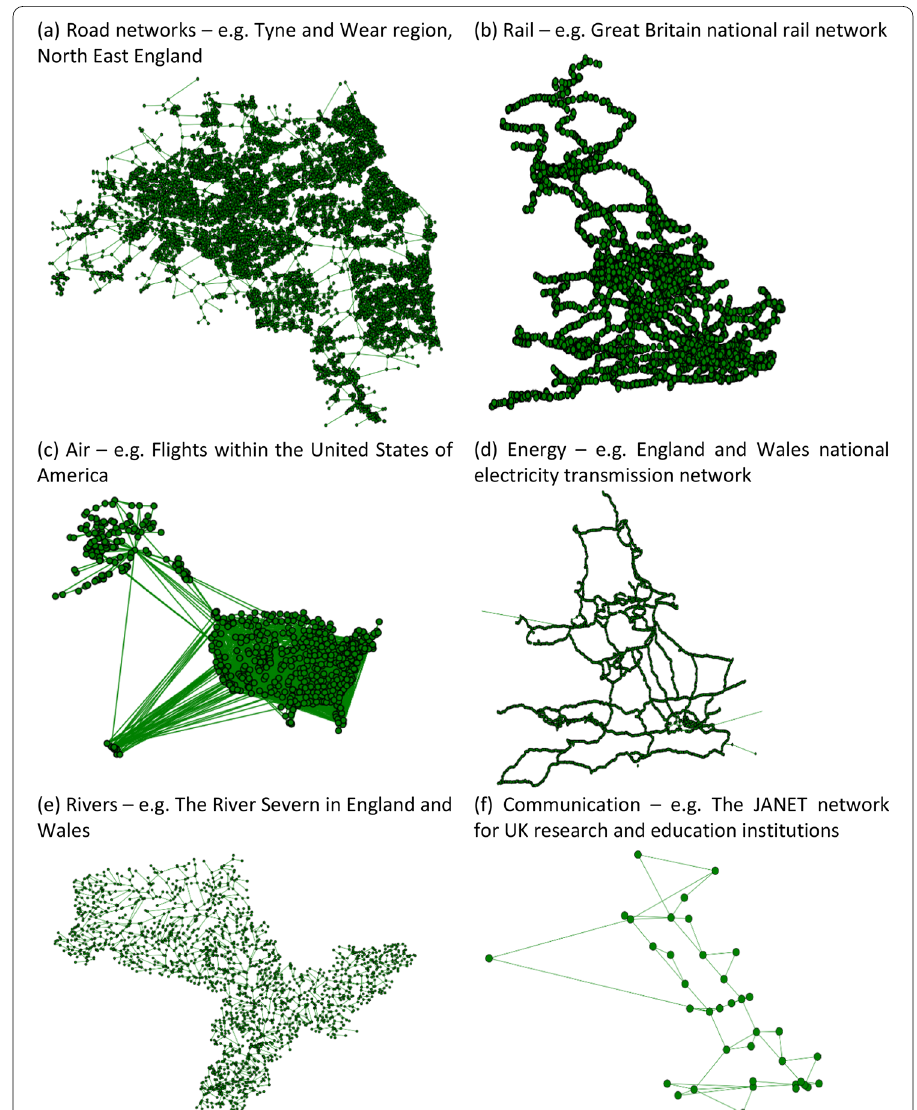
Fig. 3 Example spatial layouts for the six infrastructure